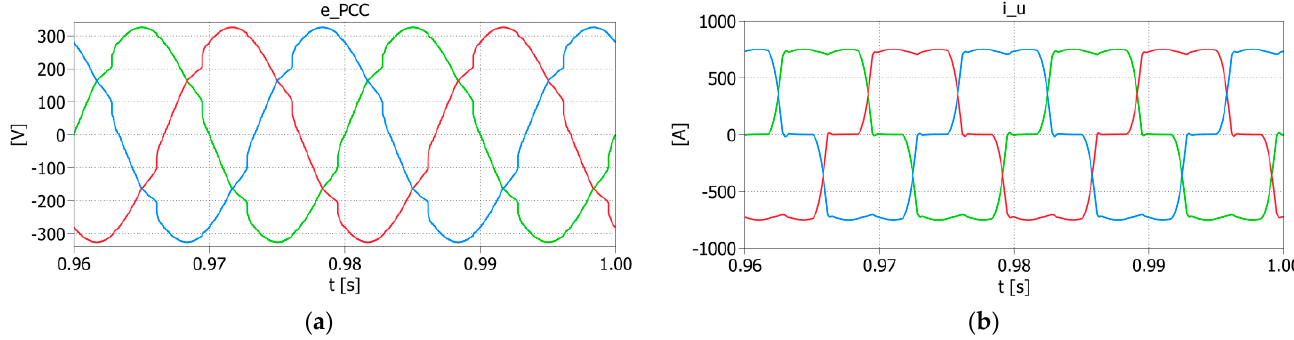
Figure 4. Harmonic compensation disabled: ( a ) voltage waveform in the PCC; THD u = 5.11%; ( b ) upstream current waveform in the PCC; THD i = 23.42%.